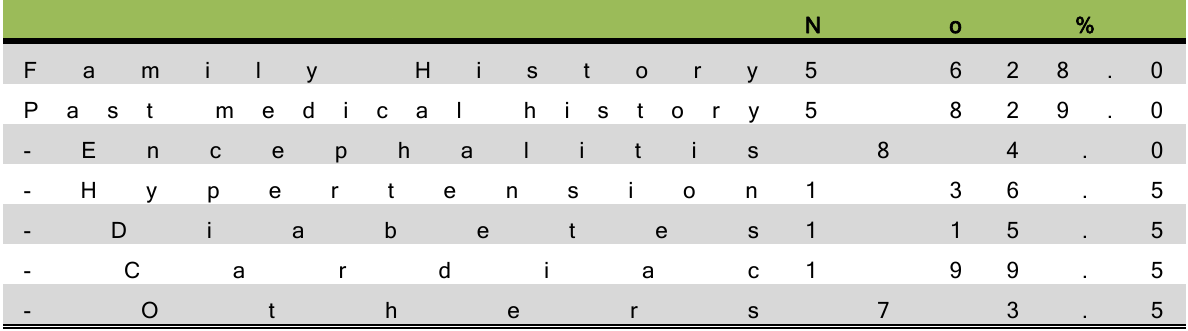
Table 7: The distribution of patients according to family and past medical history